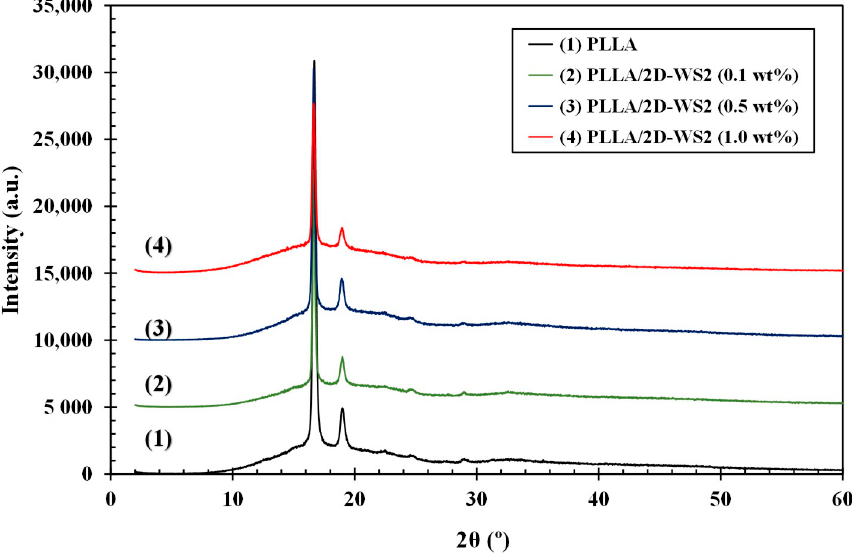
Figure 2. WAXS di ff ractograms of PLLA / 2D-WS 2 nanocomposites obtained at room temperature after Figure 2. WAXS diffractograms of PLLA/2D-WS 2 nanocomposites obtained at room temperature after cooling from the melt at 5 ◦ C / cooling from the melt at 5 °C/min.